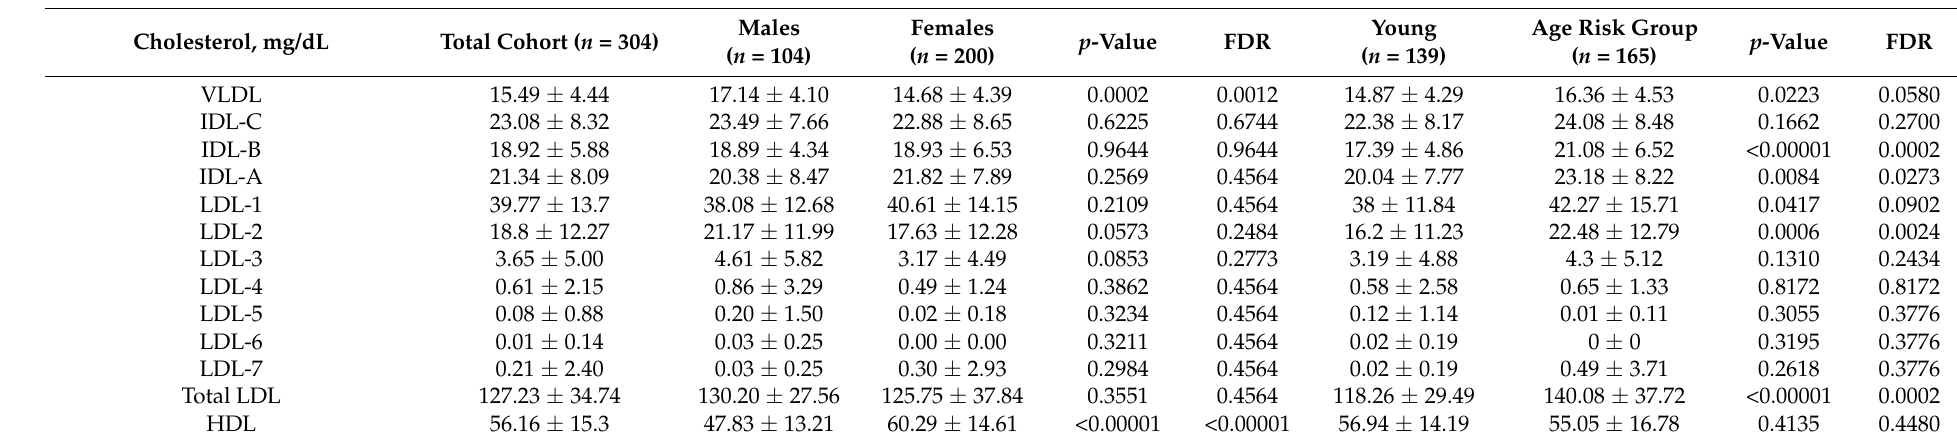
Table 2. Lipoproteins subfractions (mg/dl), sex and